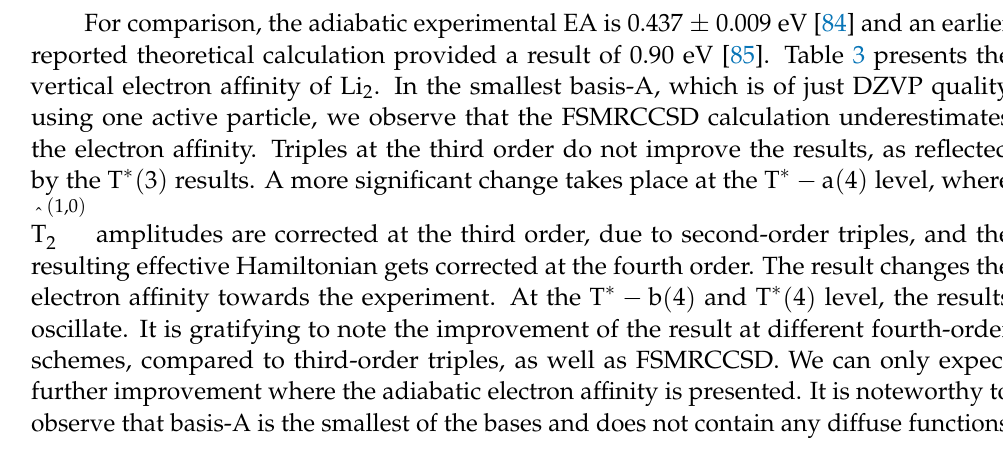
Table 3. Vertical electron affinity of Li 2 using various basis sets at inter-nuclear separation of 5.05 a. u. Results (eV) Methods Basis-A (3s2p1d) Basis-B(4s3p1d) Basis-C(4s3p1d)